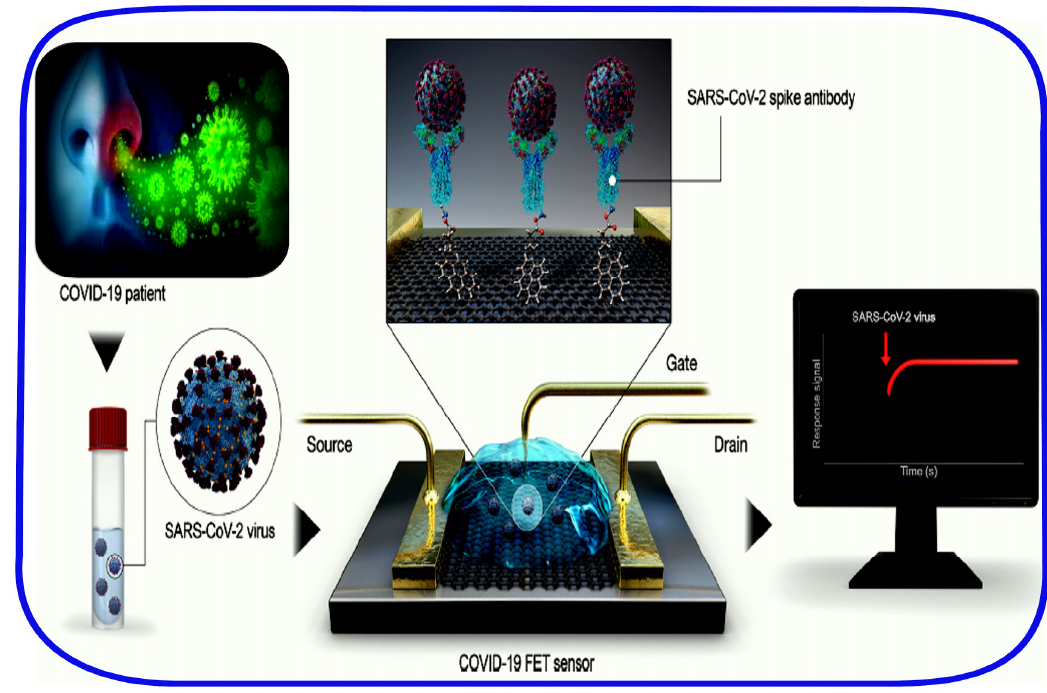
Figure 9. COVID-19 SARS-CoV-2 FET biosensor operation procedure. Graphene implemented Figure 9. COVID‐19 SARS‐CoV‐2 FET biosensor operation procedure. Graphene implemented as a as a sensing material, and SARS-CoV-2 spike antibody is conjugated onto the graphene sheet via sensing material, and SARS‐CoV‐2 spike antibody is conjugated onto the graphene sheet via 1-pyrenebutyric acid N-hydroxysuccinimide ester, which is an interfacing molecule as a probe 1‐pyrenebutyric acid N‐hydroxysuccinimide ester, which is an interfacing molecule as a probe linker. Figure adapted from [89] (Further permissions related to this figure should be directed to the ACS https://doi.org/10.1021/acsnano.0c02823).